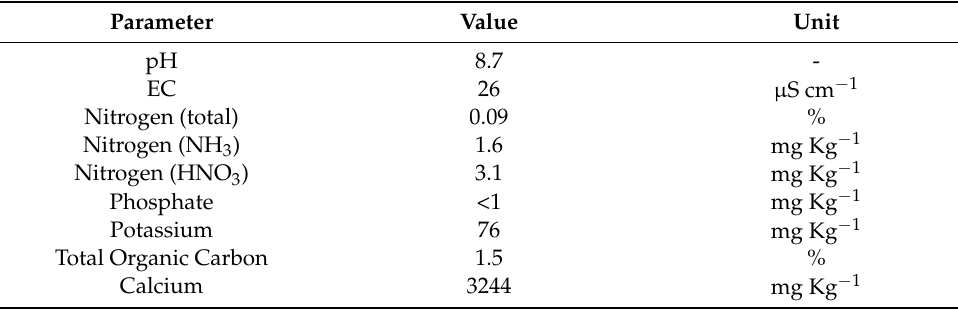
Table 1. Soil physico-chemical properties.